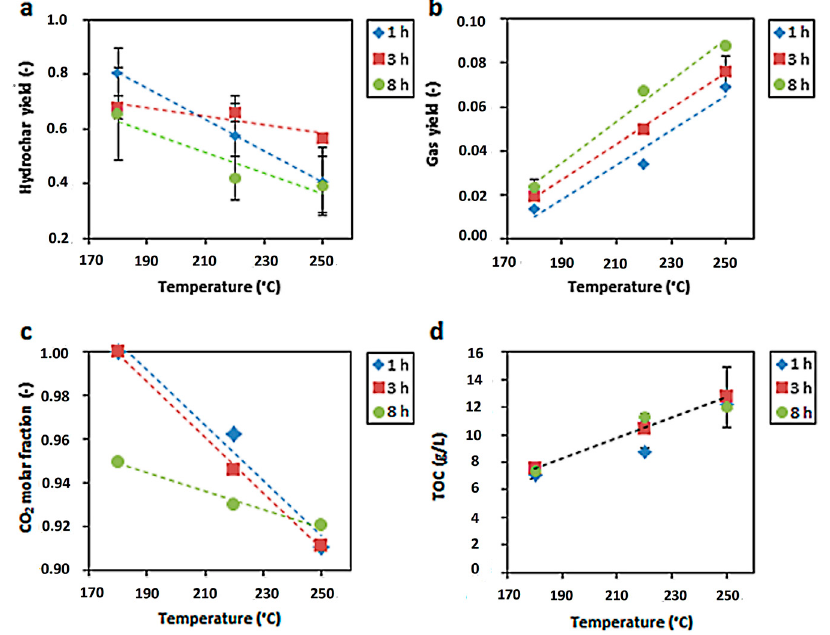
Figure 1. Interpolation of experimental data relevant to HTC of OSC. Linear correlations at different residence times (1, 3, 8 h) between temperature and: ( a ) solid yield; ( b ) gas yield; ( c ) CO 2 molar fraction; ( d ) TOC.